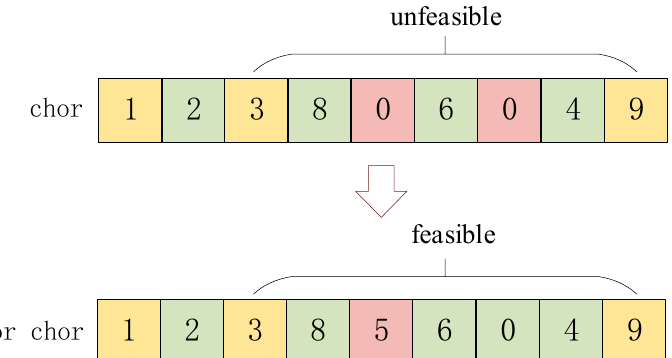
Figure 11. An illustration of chromosome correction.